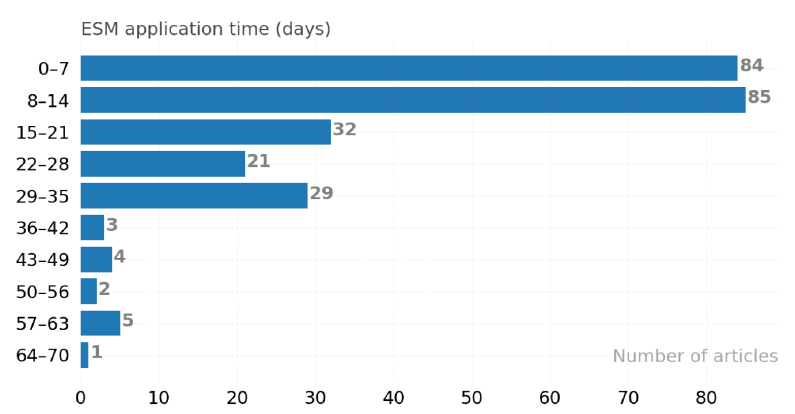
Figure 12. Time spent sampling experience.